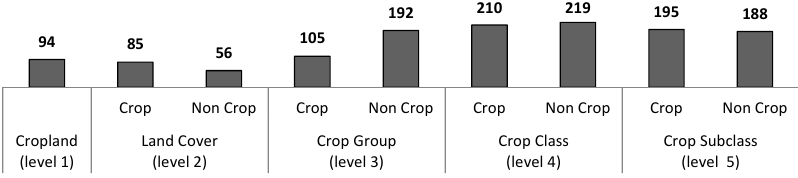
Figure 3. Evolution of cross-validated (5-fold) overall accuracy according to the number of variables used for classification at level 1 (cropland). The variables were previously ranked by order of importance based on the MDA measure.